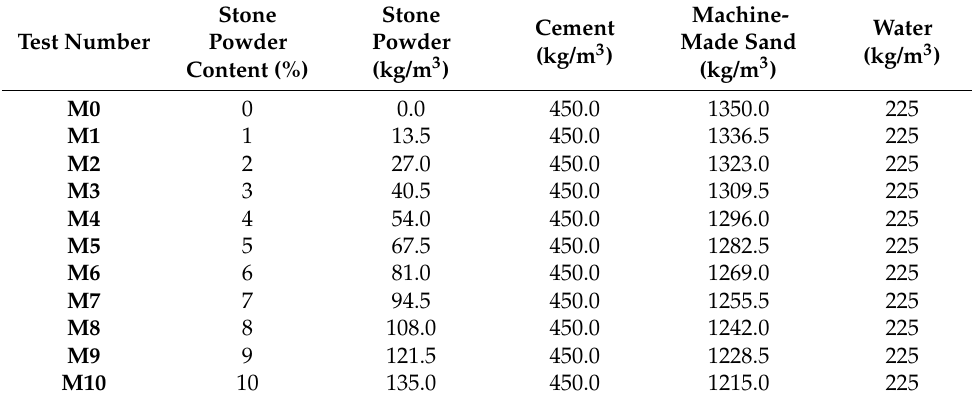
Table 3. Test of mortar strength of machine-made